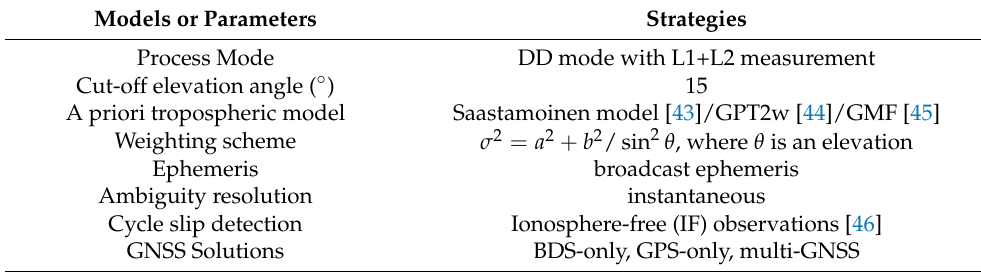
Table 3. Multi-GNSS data processing strategies in RTKLIB.